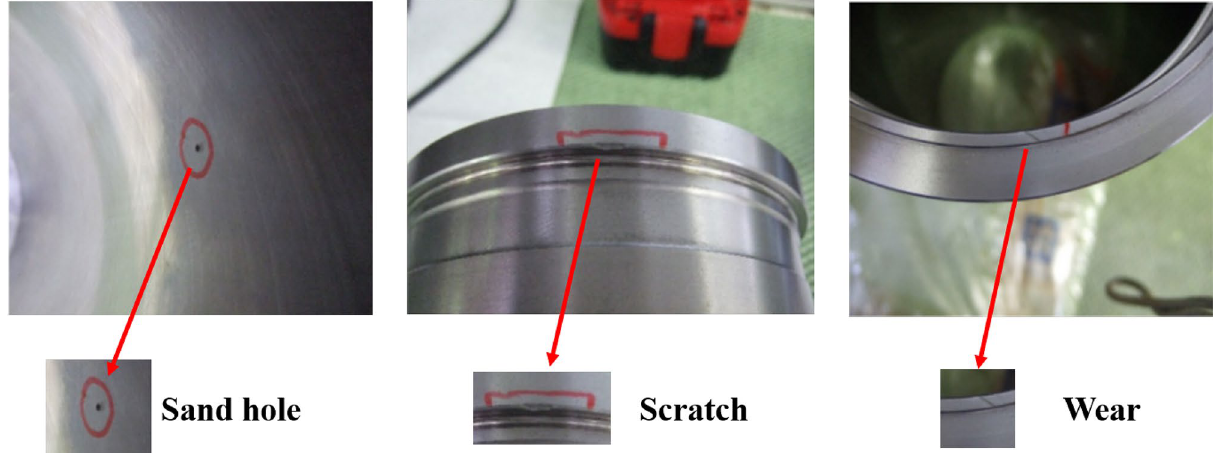
Figure 1. Three frequently occurring cylinder liner defects. The images from left to right represent sand hole, scratches, and wear,